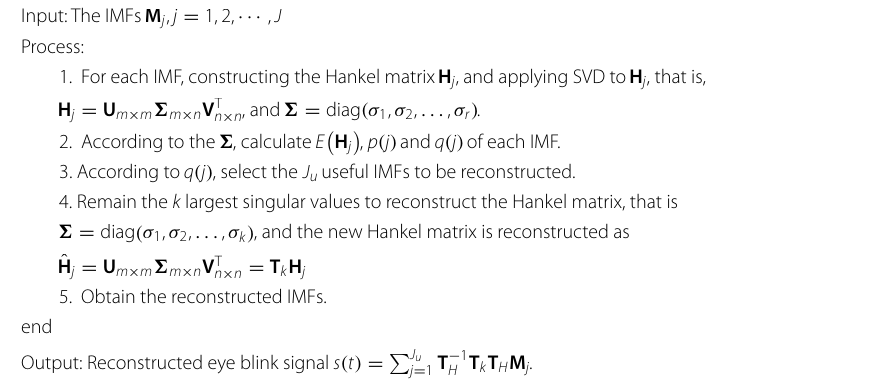
Table 2 IMFs selection and reconstruction using